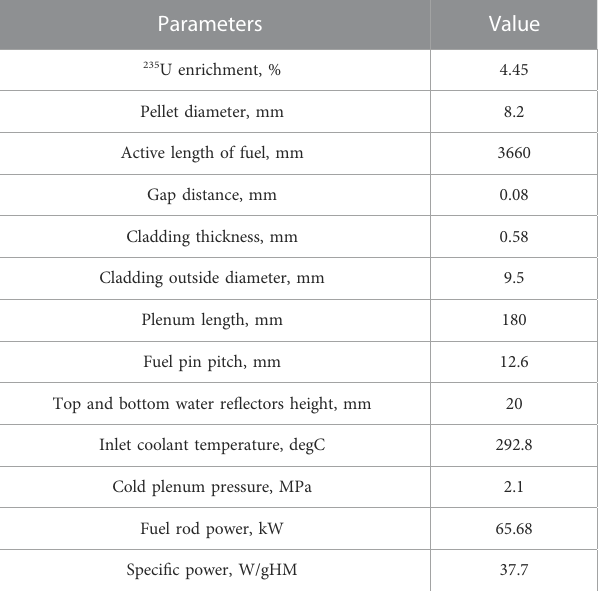
TABLE 2 Main modeling